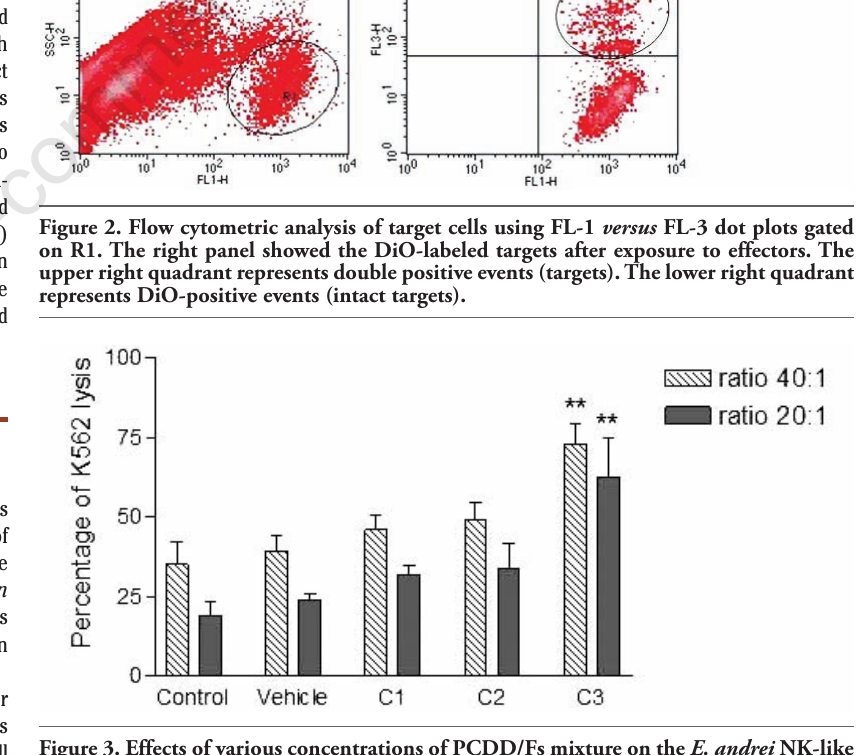
Figure 3. Effects of various concentrations of PCDD/Fs mixture on the E. andrei NK-like cell activity to lyse the human tumor cells (K562). The effectors were not washed to remove PCDD/Fs before contact with K562. Asterisks represent significant difference compared with vehicle controls (*P<0.05,